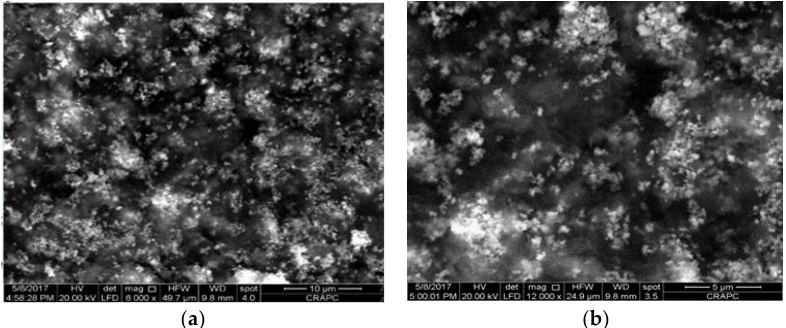
Figure 2. SEM micrographs, ( a ) 10 μm and ( b ) 5 μm, of the surface of conducting PANI@Fe 2 O 3 composites.